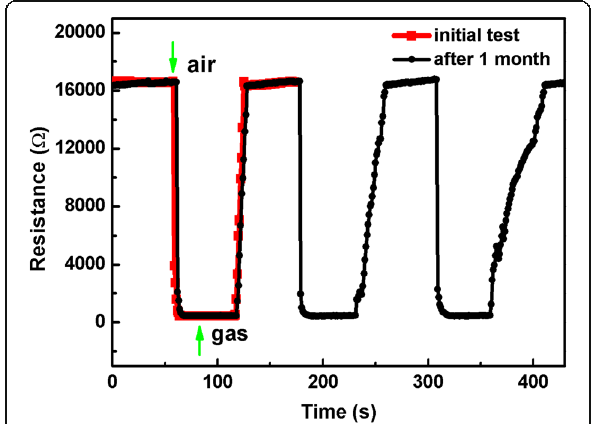
Fig. 9 Stability of S PVP over 1 month of aging for 100 ppm ethanol at 270 °C